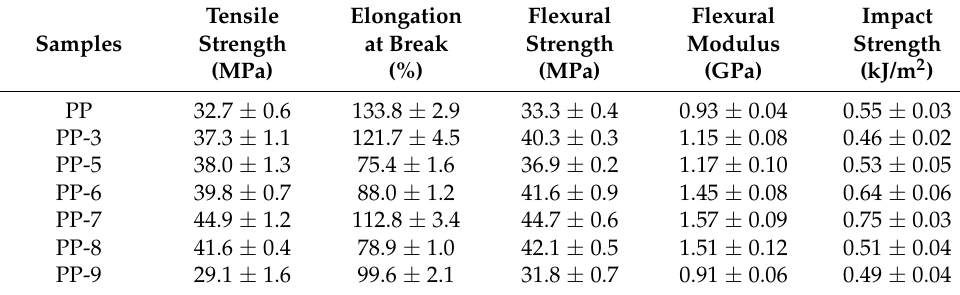
Figure 10. SEM images of the impact-fractured surface of PP ( a1 — 500×, a2 — 5000×, a3 — 20,000×), PP/20%PN-DOPO ( b1 — 500×, b2 — 5000×, b3 — 20,000×), PP/15%PN-DOPO/5%OMMT ( c1 — 500×, c2 — 5000×, c3 — 20,000×) and PP/7%OMMT ( d1 — 500×, d2 — 5000×, d3 — 20,000×) at different magni- fications.